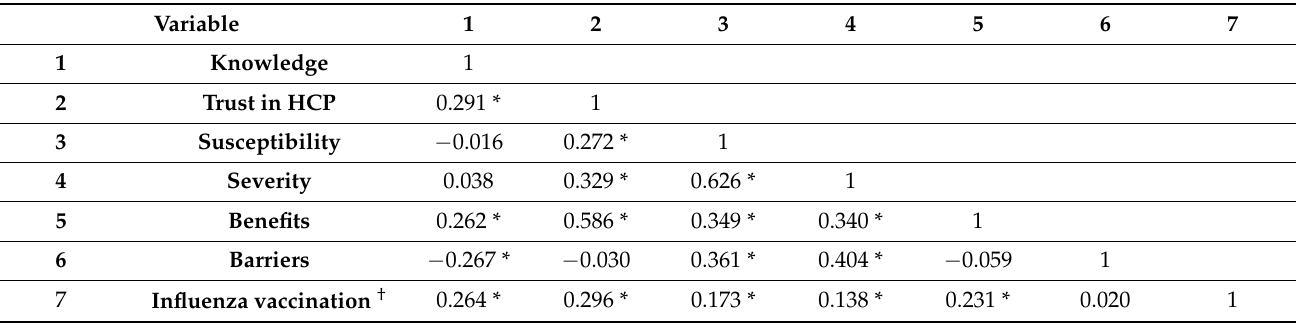
Table 4. Correlation between knowledge, trust in healthcare providers, health beliefs, and acceptance of the influenza vaccine.